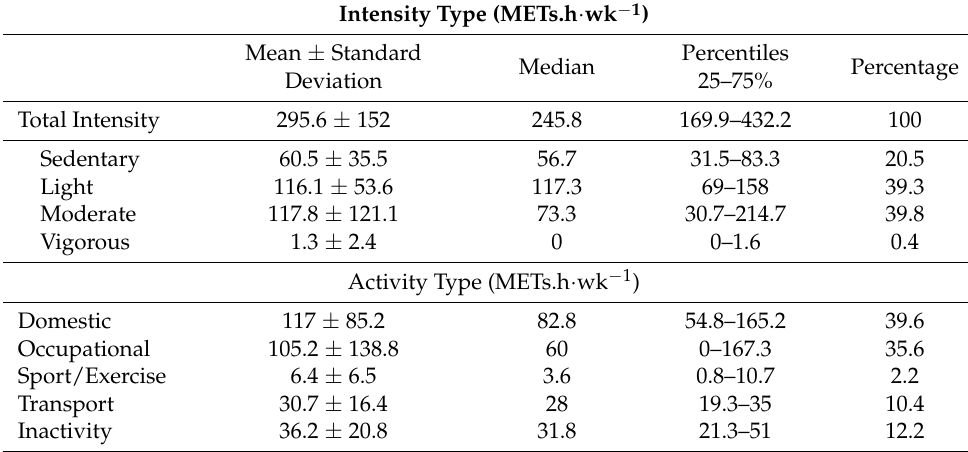
Table 2. Average of the scores of the intensity and type of PA (METs.h · wk − 1 ) self-reported through the